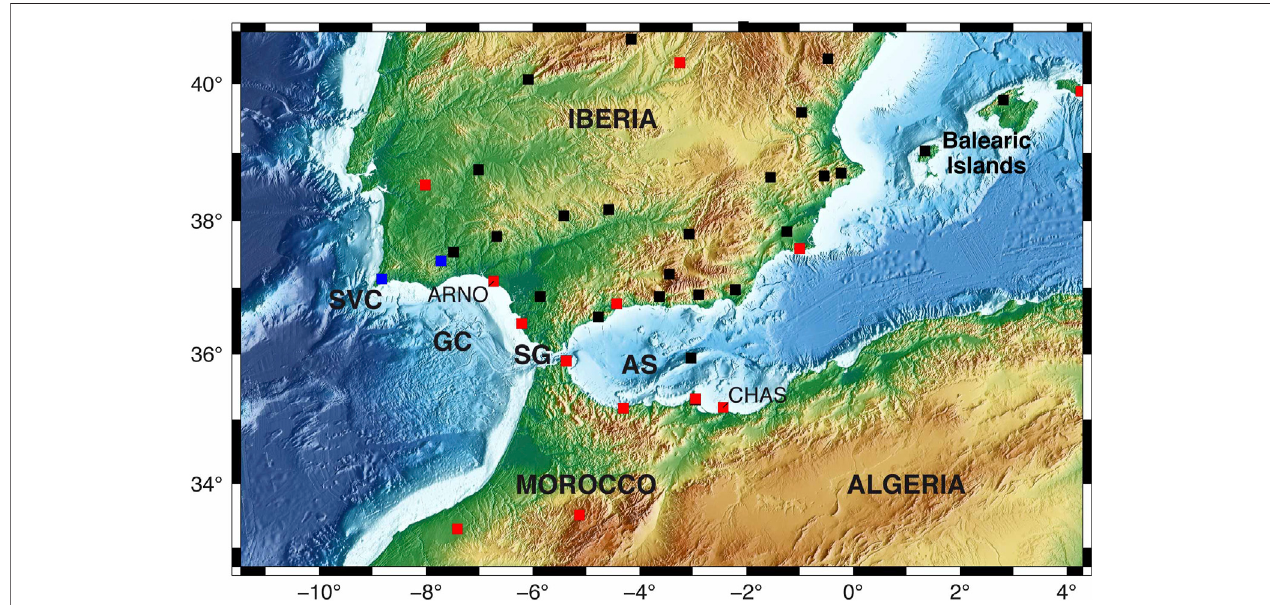
FIGURE 2 | PRESTo receiving stations. Black squares (cid:1) IGN, red (cid:1) WM, blue (cid:1) IPMA stations. SVC (cid:1) Saint Vincent Cape; GC (cid:1) Gulf of Cadiz; SG (cid:1) Strait of Gibraltar; and AS (cid:1) Alboran Sea.